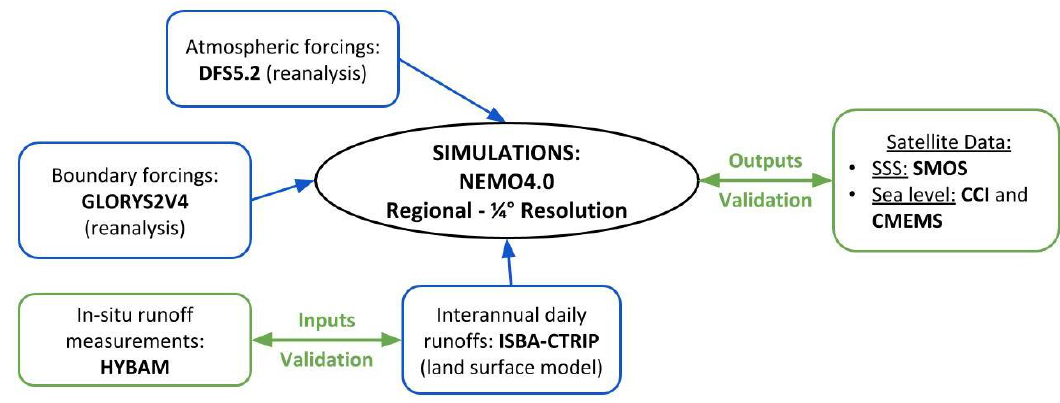
Figure 1. Model configuration and data used for validation.